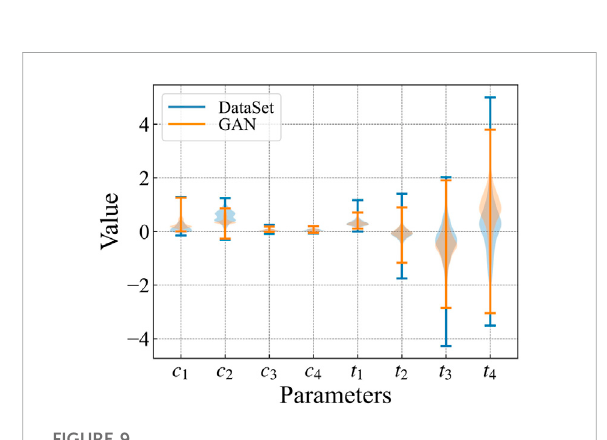
FIGURE 9 TheIPGparameterdistributionoftheWGANgeneratedairfoil and the data set